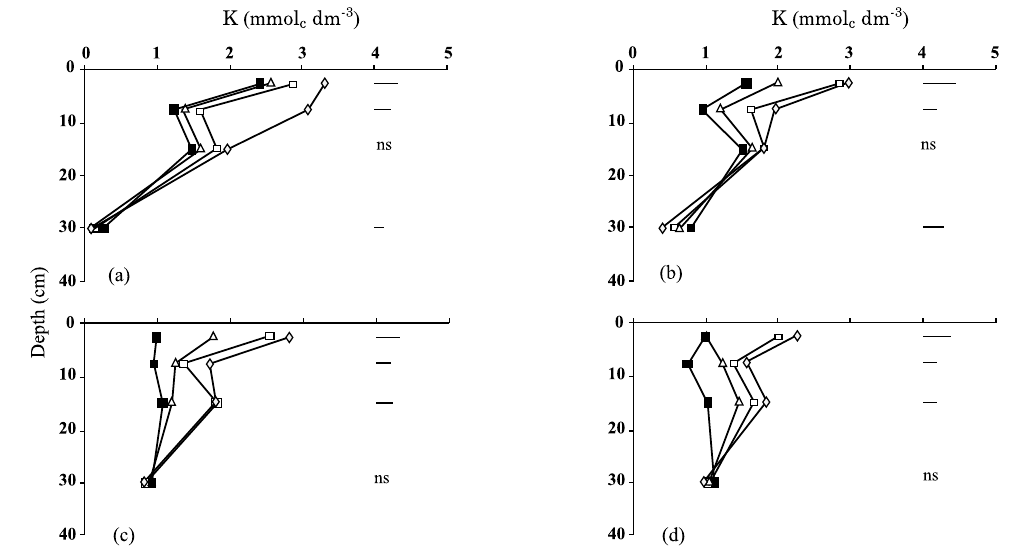
Figure 5. Potassium levels in the soil profile as affected by nitrogen fertilization ( ): 0; ( ): 50; ( ΔΔ ΔΔ Δ ): 100 and ( ): 150 kg ha -1 of N, 18 months after liming ((a): 0; (b): 1500; (c): 3000 and (d): 6000 kg ha -1 of lime). : least significant difference at 5 % by the t test. ns: non significant.